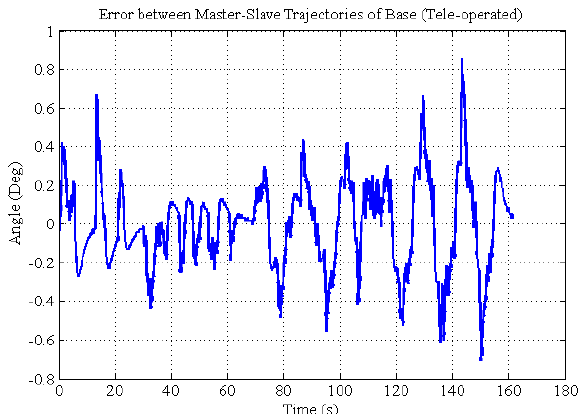
Figure 21. Error between the base trajectories for master and slave.